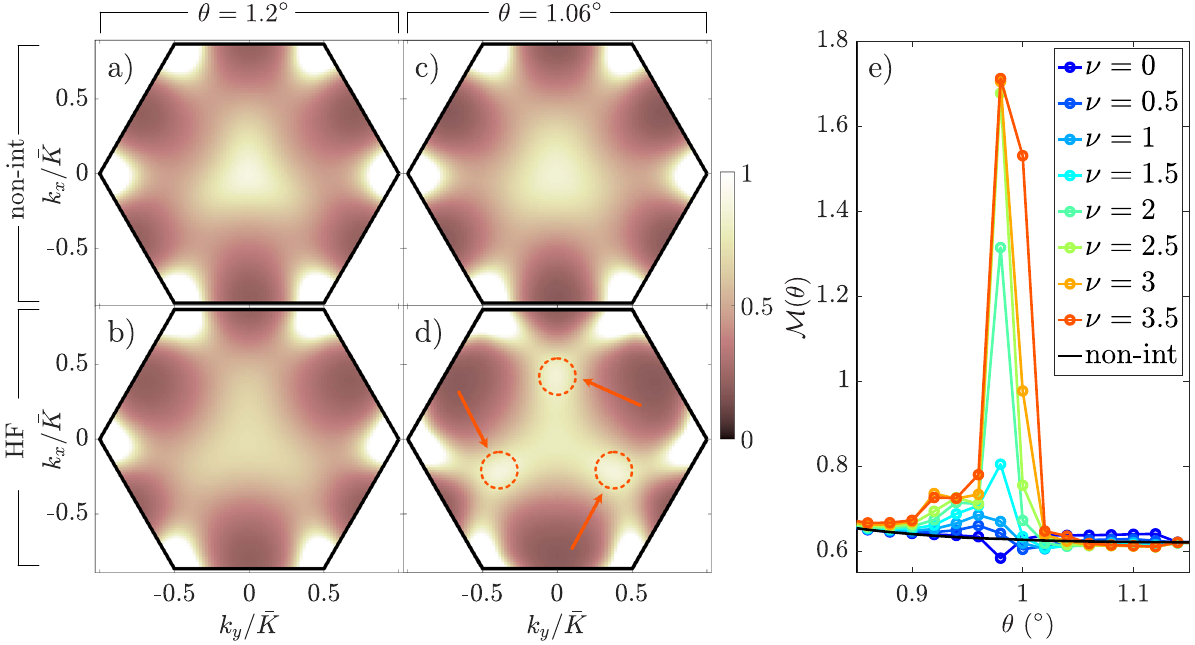
Fig. 3 HF-driven modi fi cation of the Fubini – Study metric. Tr ð g αβ Þ for θ = 1.20°, 1.06° for a , c noninteracting, and b , d HF-corrected bandstructures for valley ξ = − 1 at a fi lling of ν = 4. The behavior changes qualitatively near magic-angle (1.06°) with and without interactions. In panels a – d , we saturate the color scale to help delineate the features near the center of the MBZ. e A comparison of M for the HF-corrected bandstructure as a function of twist angle and fi lling with the noninteracting result. There is a dramatic enhancement in M for θ and ν where the tendency towards band inversion is most